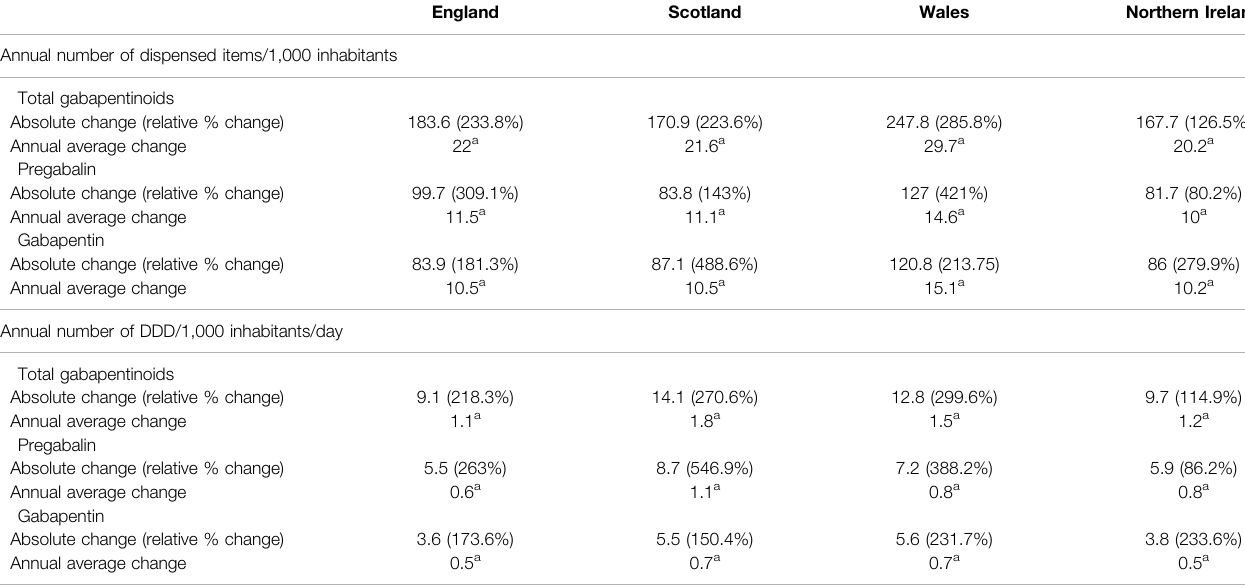
TABLE 2 | Absolute, relative, and average annual changes in the utilisation trends of gabapentinoids across England, Scotland, Wales and Northern Ireland over the study period from 2010 to